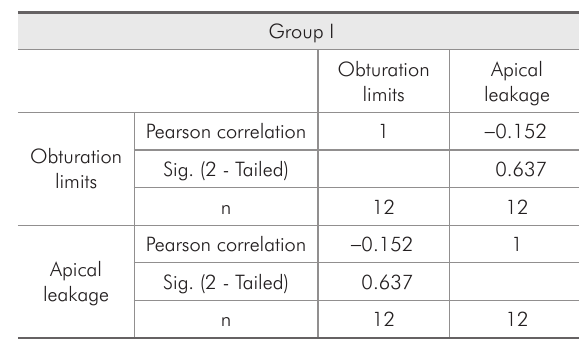
Table 1 - Correlation analysis of Group I.